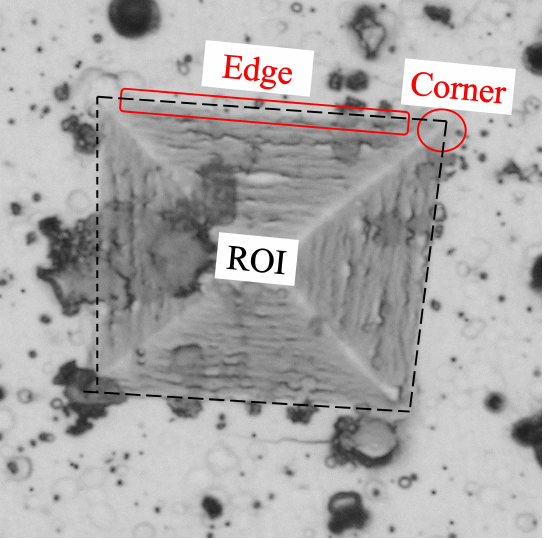
Figure 3. Details of the indentation image that affect the hardness measurement. Corner and edge defects and background